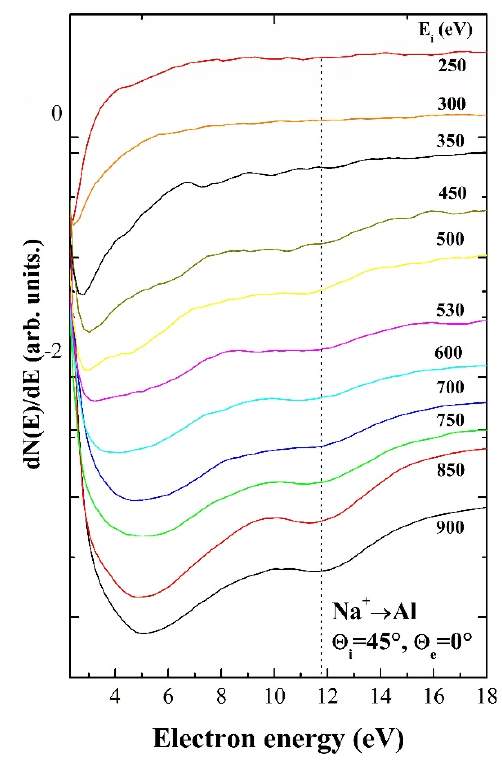
Figure 6. derivatives of the spectra in Figure 5 that show the bulk plasmon dip.